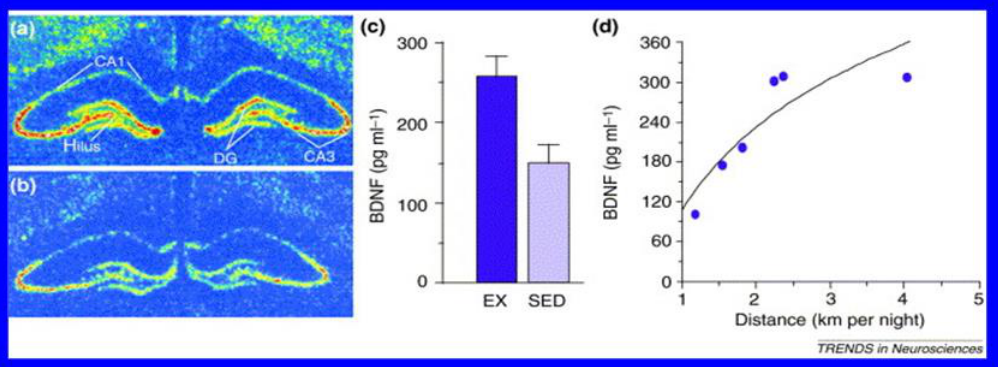
Figure 5. BDNF increases in mouse hippocampus ( a ) After 7 days of volunteer wheel running compared to ( b ) sedentary (SED) mice. ( c ) BDNF levels as a function of exercise (EX) v. sedentary behavior (SED) ( d ) correlation between the distance of wheel running and BDNF levels. (with permission [79]).